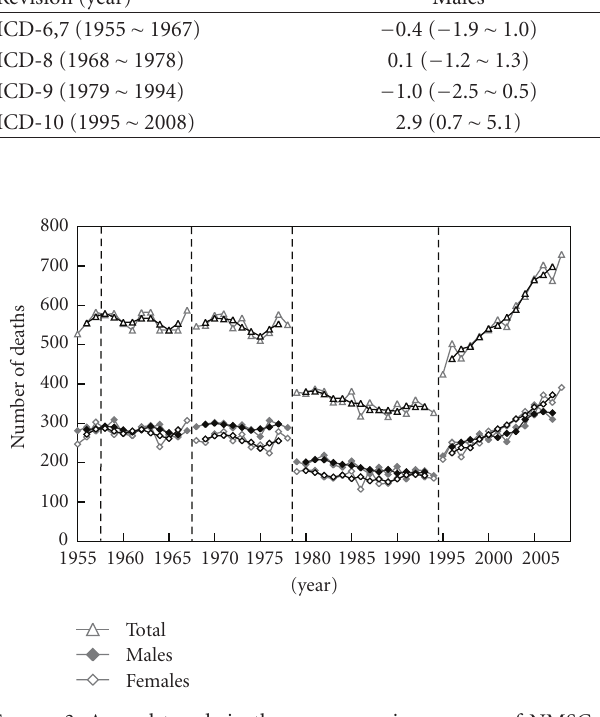
Figure 3: Annual trends in three-year moving average of NMSC in 1955–1967, 1968–1978, 1979–1994, and 1995–2008 in Japan, modified from Ohtsuka and Nagamatsu [7].